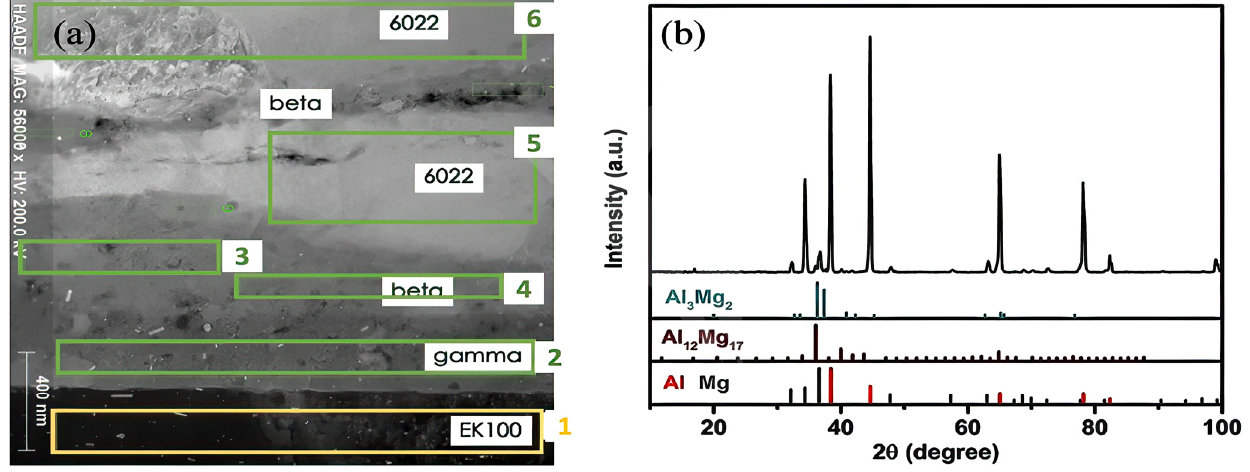
Table 2. Index of EDS line-scan results from Figure 7a.